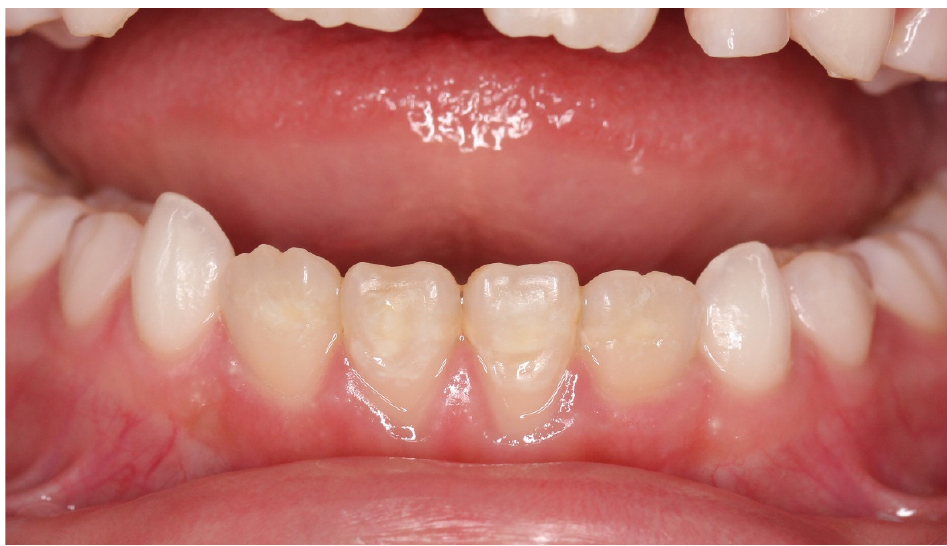
Figure 5. Case 1: Intraoral photograph after seven-times treatment. Table 1. In Case 1, the cloudiness and brown areas from the pre-treatment (before applications) and post-treatment (after 7 applications) images were measured as pixels by digital image analysis. The analysis was performed three times and the mean measures and standard deviations were calcu- lated (mean ± SD). The significance of the differences in areas before and after treatment was eval- uated with p- values by t- test.